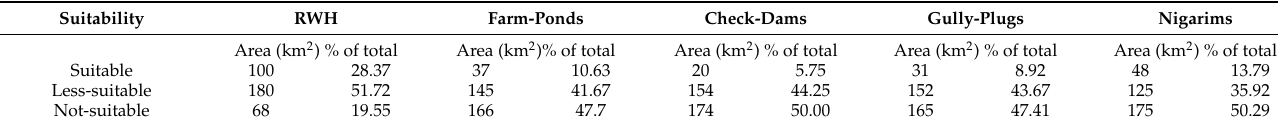
Table 5. Distribution of potential sites for RWH and related structures in the study area.